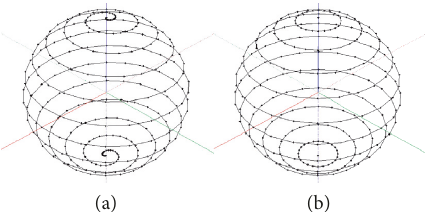
Figure 7: Spiral scan measurement points (a) and standard (equally spaced) measurement points